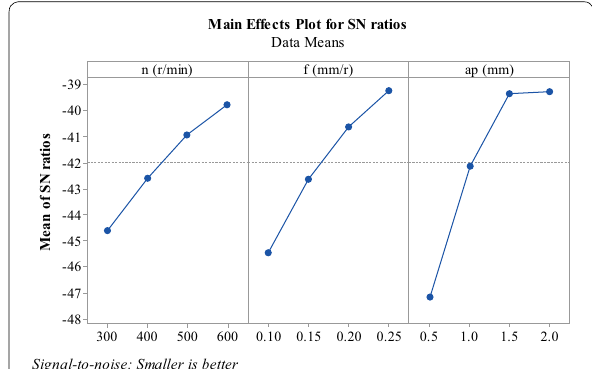
Figure 6 Main effects plot for processing time